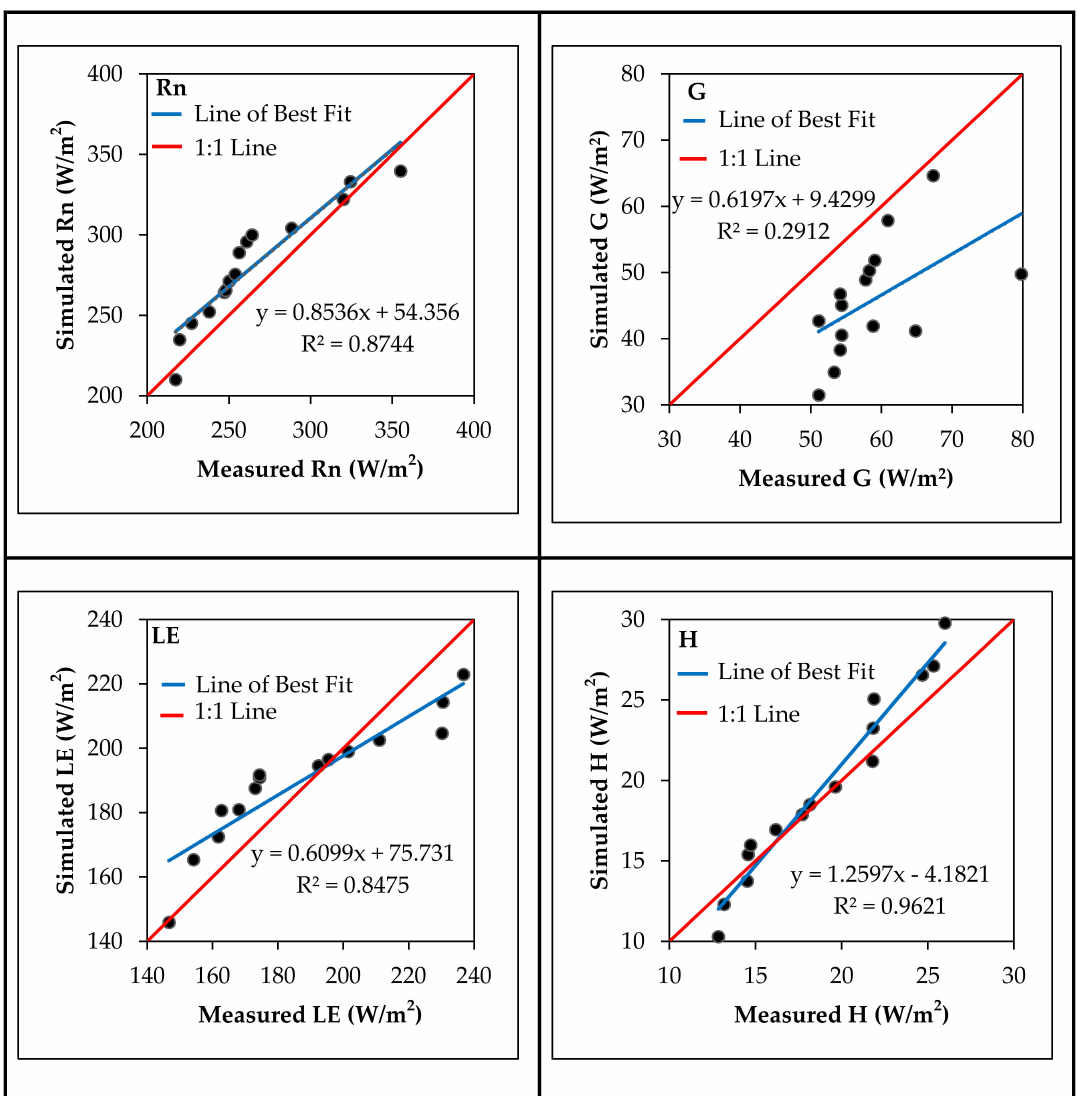
Figure 9. Scatterplots of the novel TSEB-derived energy fluxes versus EC tower-based